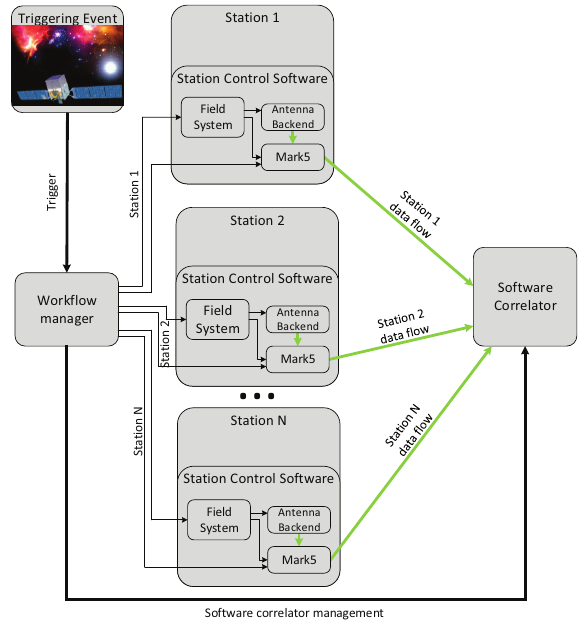
Fig. 8. Schematic diagram of the triggered e-VLBI